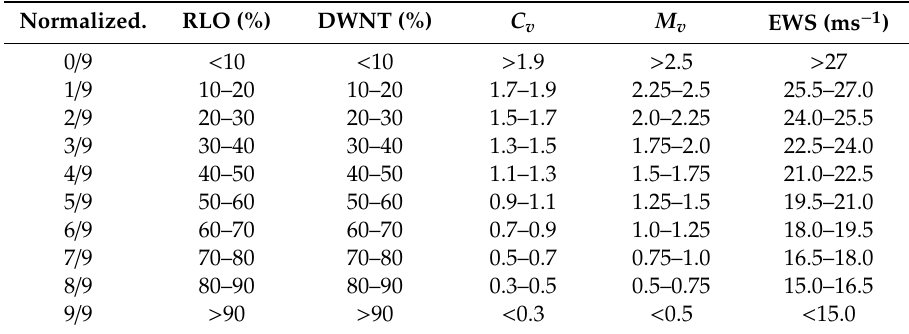
Table 2. Normalization criterion used for rich level occurrence (RLO), downtime (DWNT), coe ffi cient of variation index ( C v ), monthly variability index ( M v ), and extreme wind speeds (EWS) indices related to richness factors, variability factors, and environmental risk factors. Normalized.